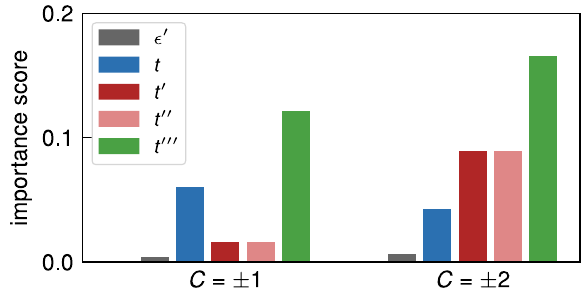
Fig. 5 Importance score. Importance score de fi ned by the Bhattacharyya distance D B ( p C ( x i ), p 0 ( x i )) (Eq. (3)) for phases with C = ±1 (left) and C = ±2 (right) of the C 6 symmetric model for the 2 × 2 kagome superlattice. The distinct features x i are ϵ , ϵ 0 , t , t 0 , t 00 and t 000 as de fi ned in the main